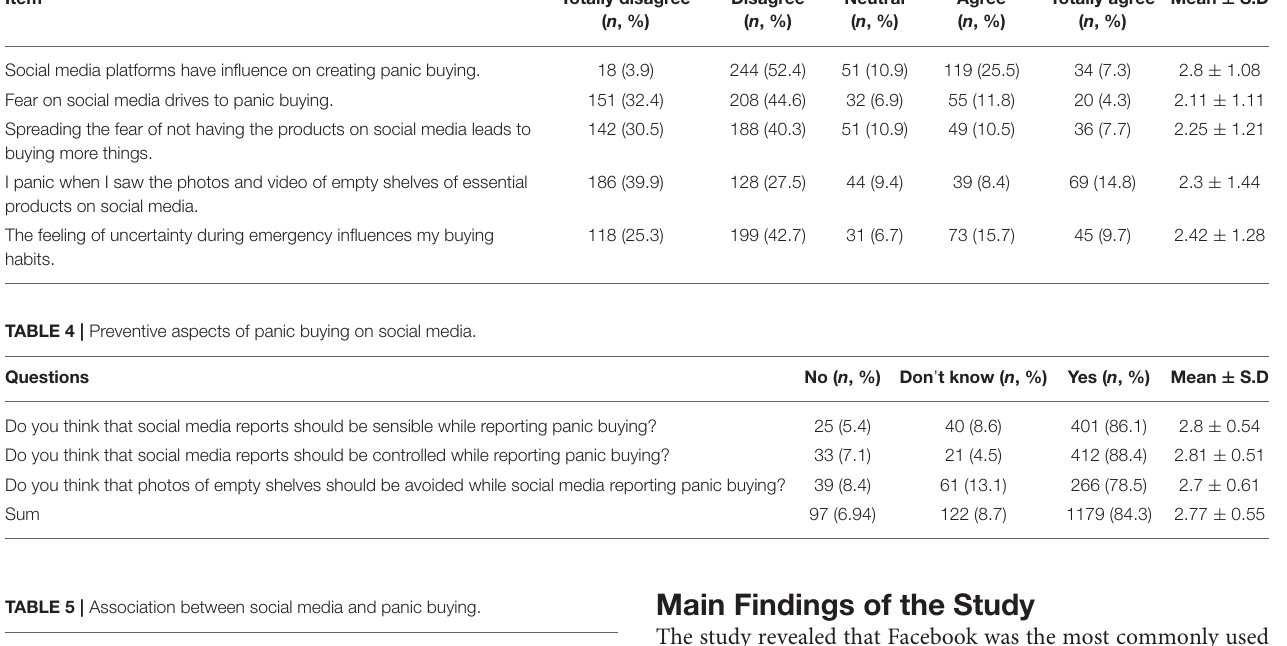
TABLE 3 | Perceived influence of social media on panic buying. Item